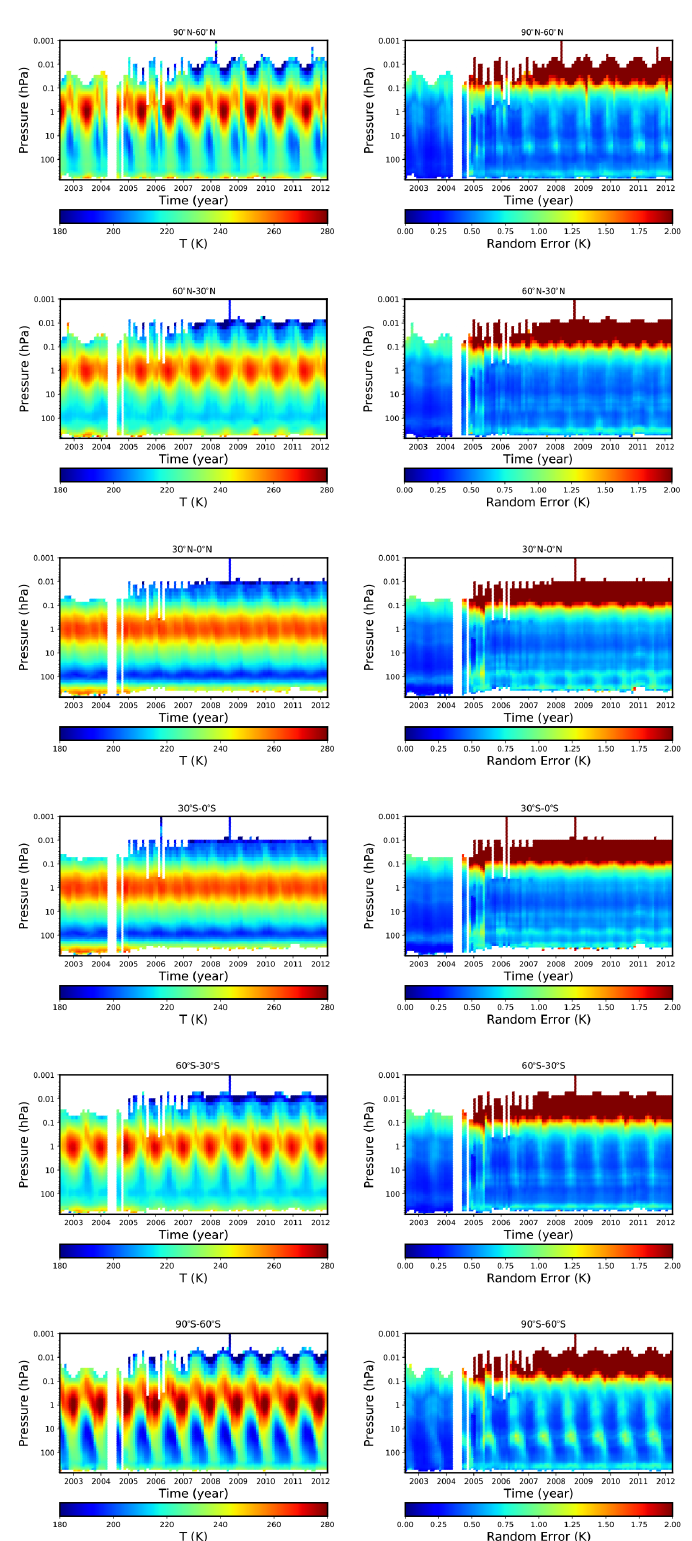
Figure 10. Time series of the monthly means of the temperature (left panels) and their random errors (right panels) as a function of pressure for the same latitude bands of Fig. 9. From top to bottom: polar north, midlatitude north, equatorial north, equatorial south, midlatitude south, and polar